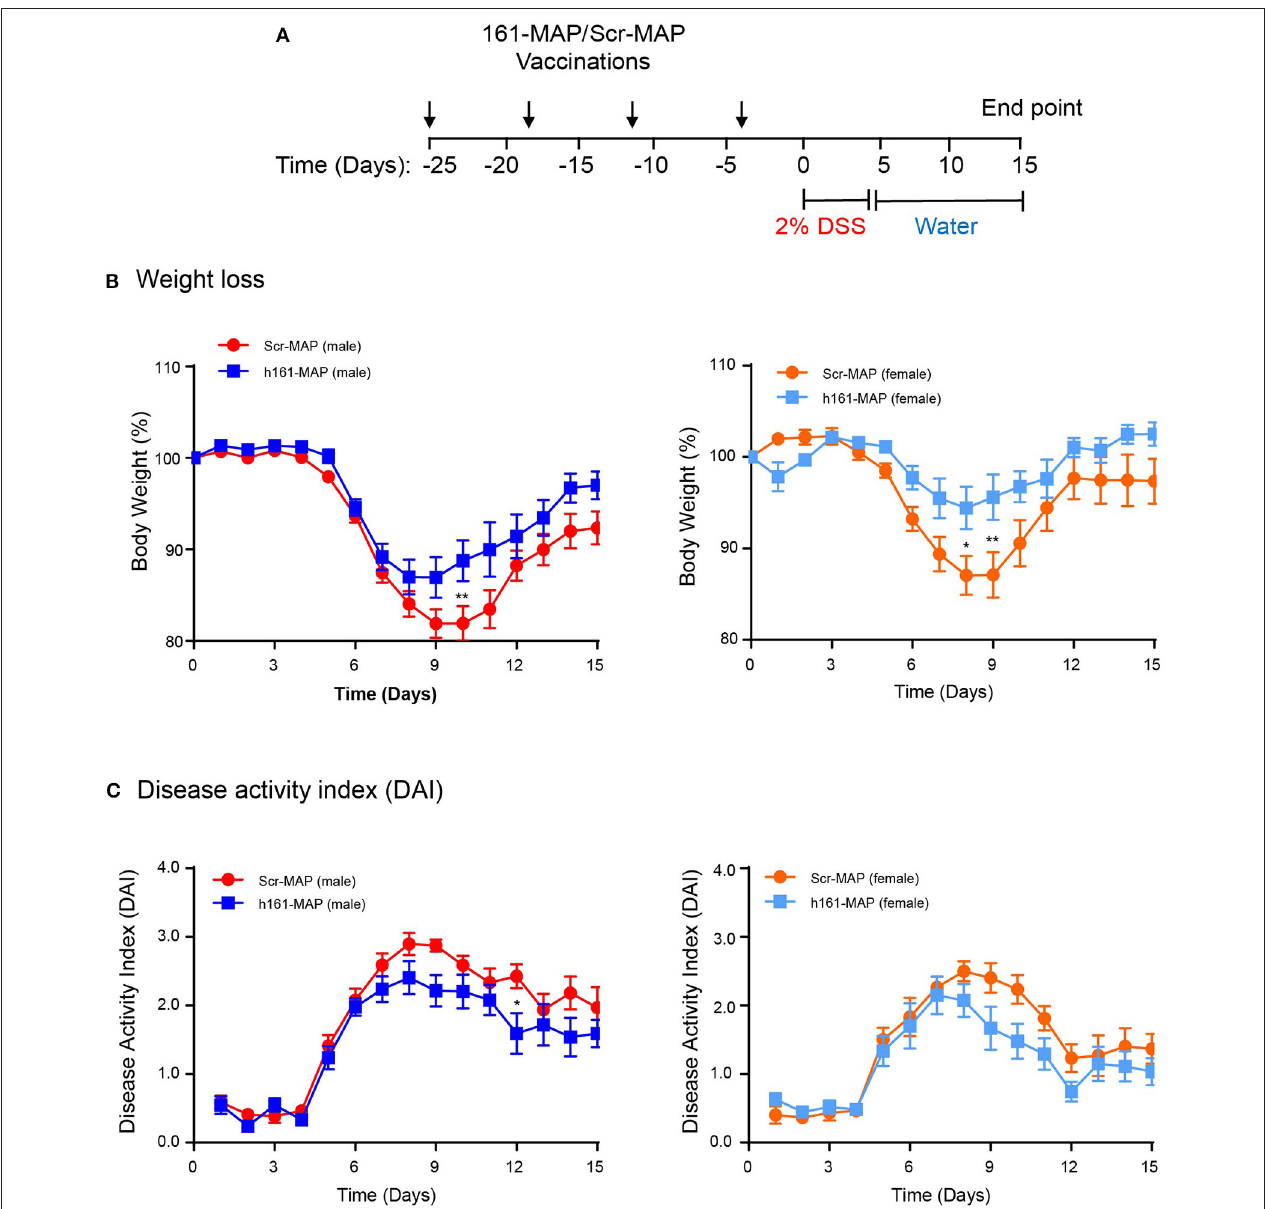
FIGURE 1 | 161-MAP active vaccination improves disease severity. (A) The experimental design is shown. Male and female C57Bl/6J mice were randomly assigned to the Scr-MAP vaccinated control group, or to the 161-MAP vaccinated experimental group. Mice received four vaccine boost injections every 7 days (arrows) prior to administration of 2% DSS in their drinking water for 5 consecutive days (marked). For the remaining time the mice received regular water, and after 10 days they were euthanized. After receiving DSS, mice were monitored daily and their (B) loss of weight or (C) the disease activity index (DAI) were observed ( n = 12 for male mice, n = 9 for female mice). * p < 0.05, ** p < 0.01 relative to the Scr-MAP vaccinated mice at the same